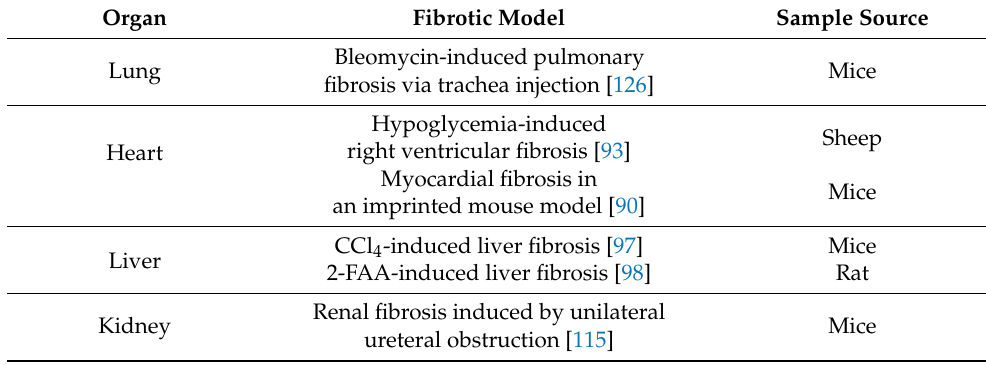
Table 3. Verified IGF-2-overexpressed animal organ fibrosis